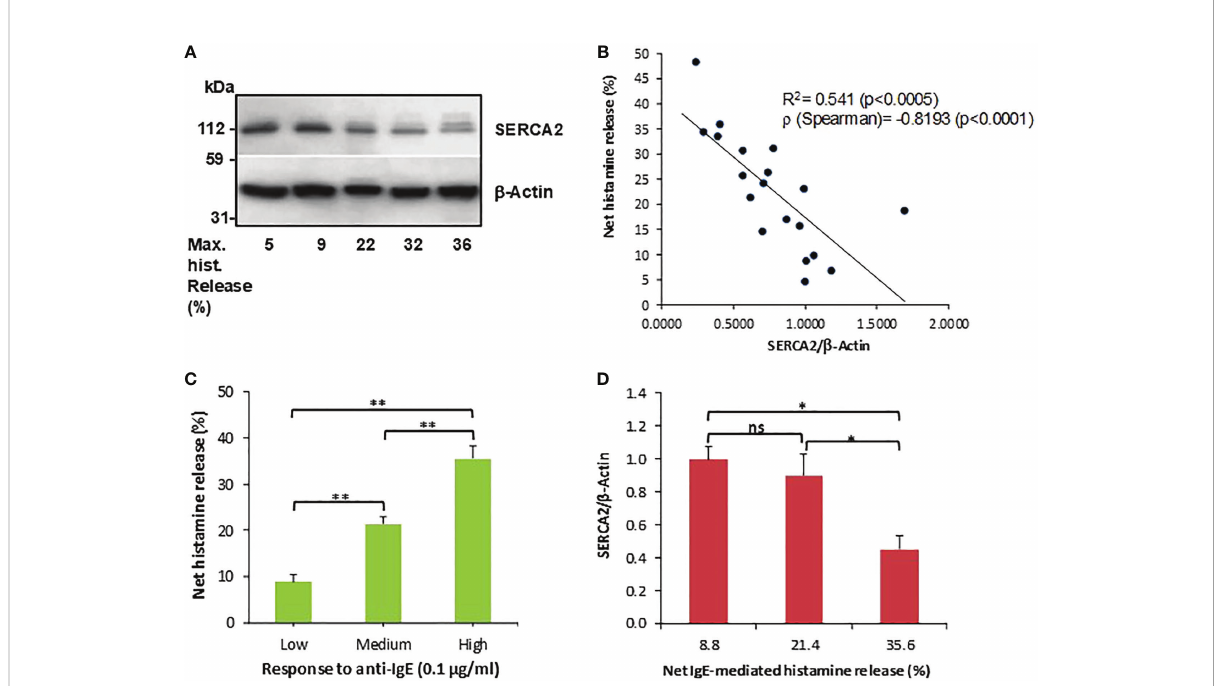
FIGURE 1 SERCA2 expressions and IgE-dependent histamine release from human basophils are negatively correlated. (A) SERCA2 expressions in unstimulated puri fi ed basophils, as determined by Western blotting, representative for a total of 19 separate basophil donors investigated. (B) Densitometric analysis of SERCA2 expressions plotted against the corresponding net anti-IgE-induced histamine release from the same basophil donors (n=19). (C) Histamine releasability to IgE-dependent stimulation grouped to low (<15% net release, n=5), medium (15 - 30% net release, n=8) and high (>30% net release, n=6) responders which were employed in (D) showing that SERCA2 expressions are clearly and signi fi cantly reduced in high responder basophils. Histamine data are shown as means ± SEM. * and ** indicate signi fi cant (p<0.05 and p<0.01, respectively) differences as determined by a one-way ANOVA followed by Holm-Bonferroni correction. ns, not signi fi